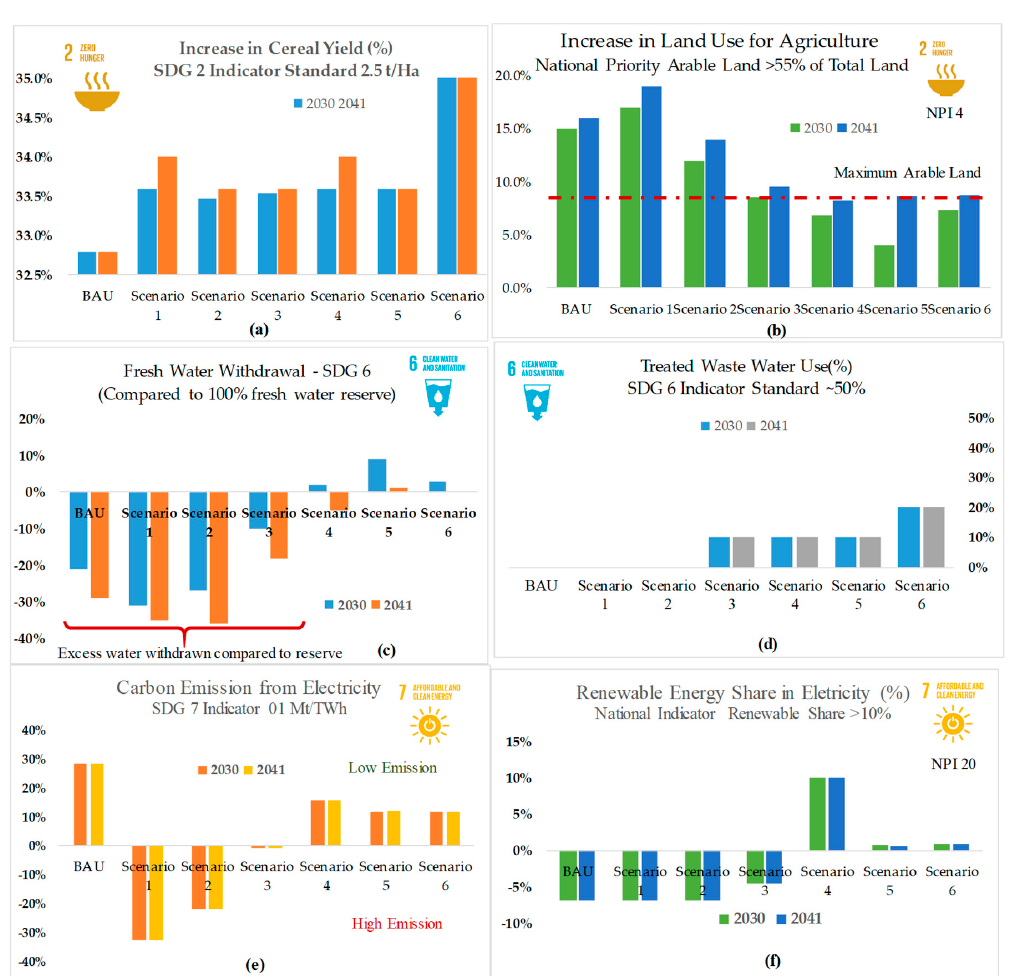
Commented [M17]: Please changethe hyphen to minus.